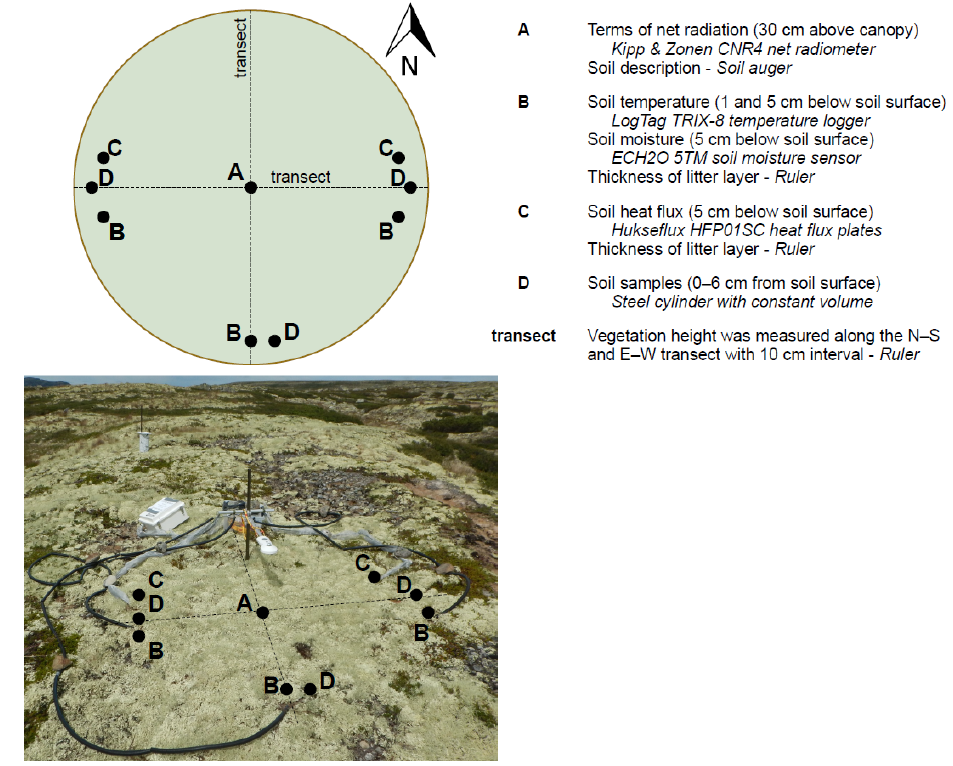
Figure 2. A schematic overview of the positions of the measurements within one plot, a picture of the setup and a list of measured variables per plot. The sensors and materials are indicated in italic. All variables were measured at the same positions within all lichen and shrub plots.